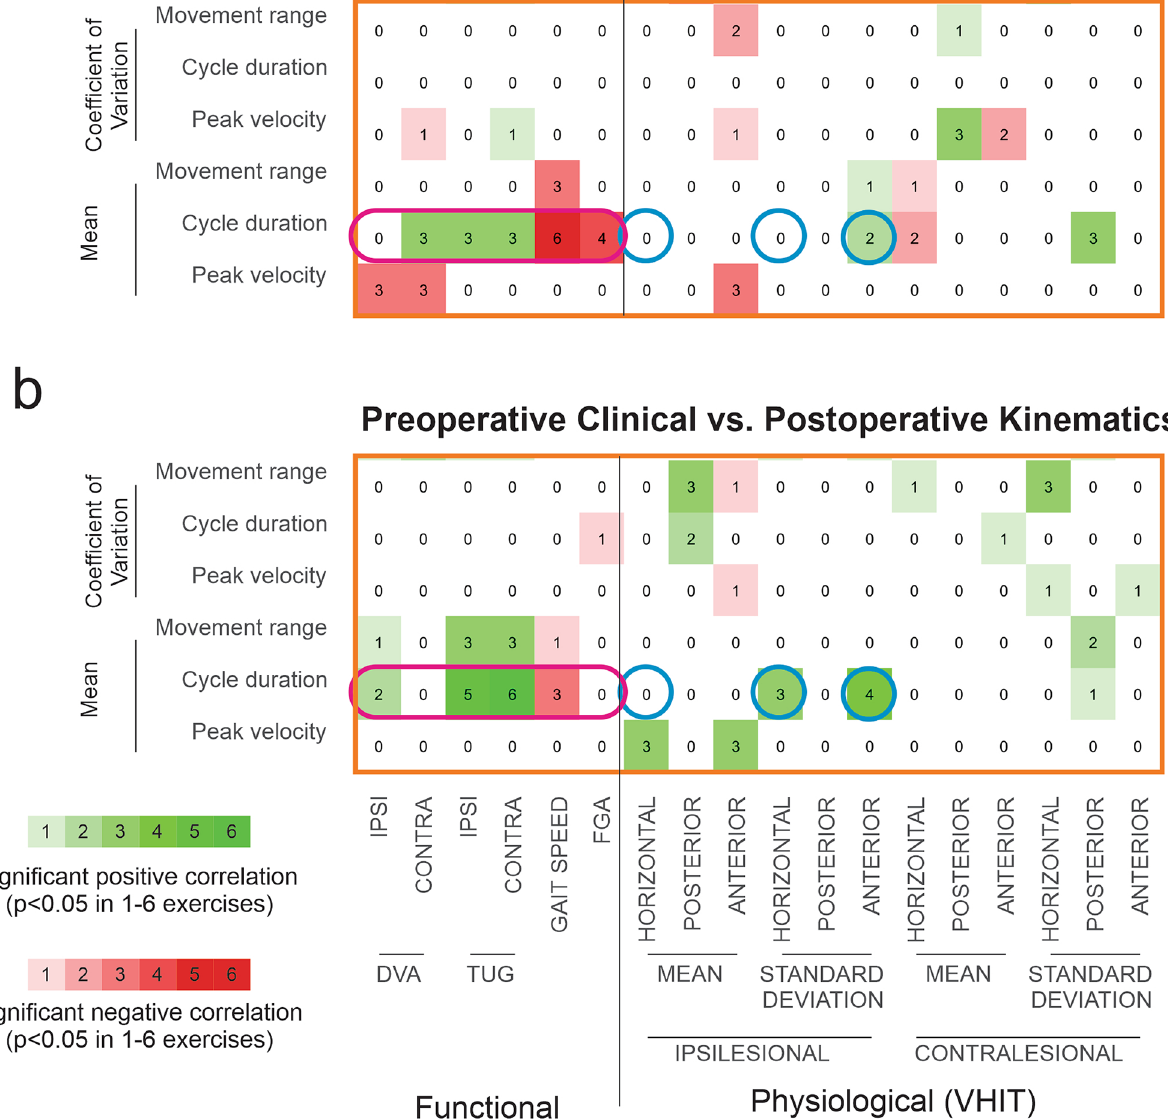
Figure 5. Correlations between post-surgery kinematic measurements and ( a ) post- and ( b ) pre-surgery clinical measurements. Green squares indicate positive correlations and red squares indicate negative correlations. Brightness and number in the square indicate the number of exercises (1–6) showing a significant correlation (p <